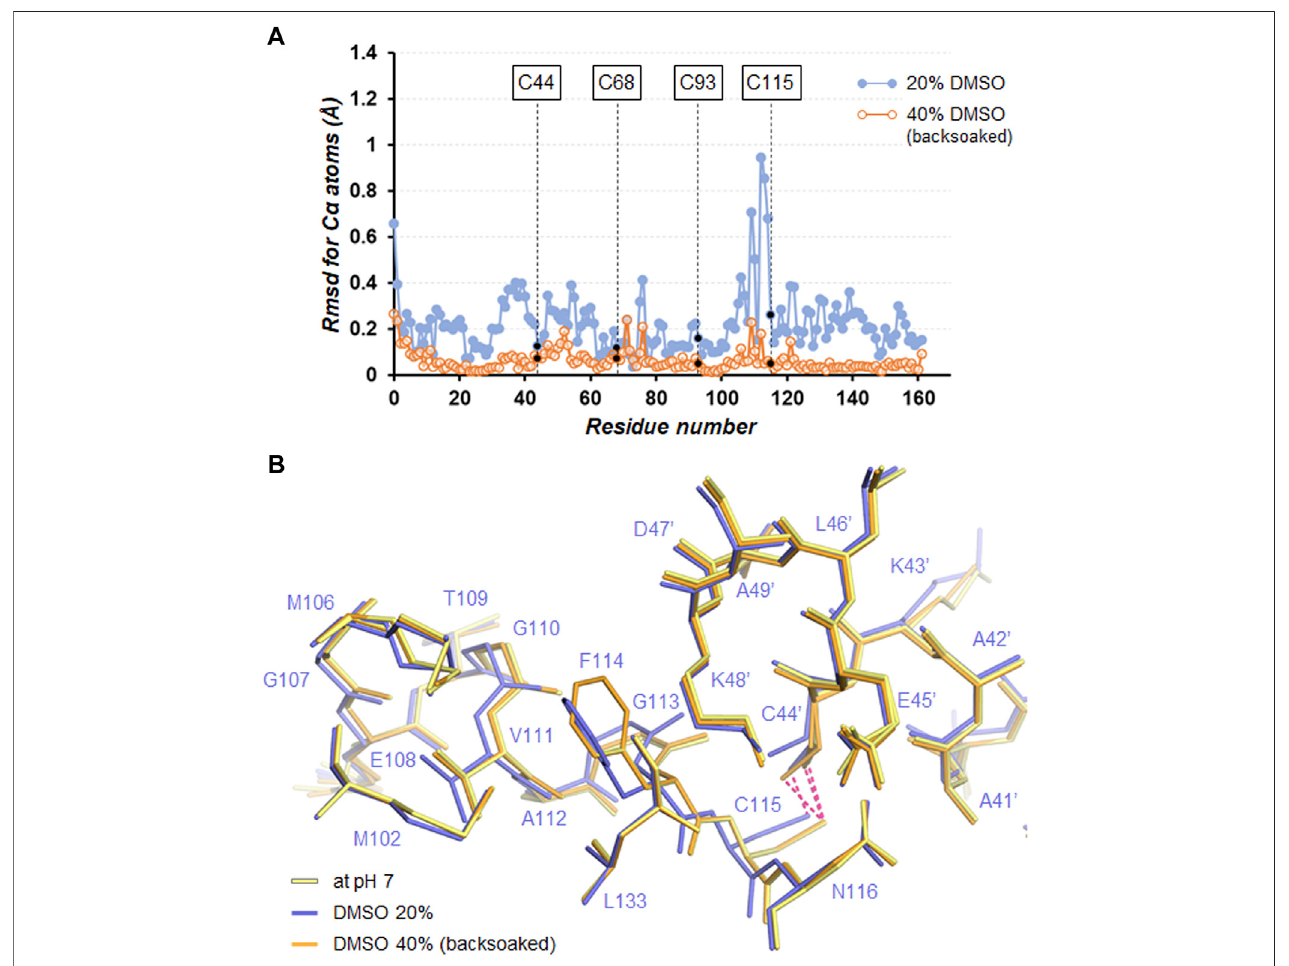
FIGURE6|(A) Plot ofthermsdvalues forC α atomsbetweenthestructuresintheabsenceorpresence ofDMSO withrespecttothatat pH7. (B) Close-upviewof the Cys115 − Cys44 ’ cross-link site. Superimposed molecules are shown by line representation. The disul fi de bonds are depicted by hotpink dashed lines.